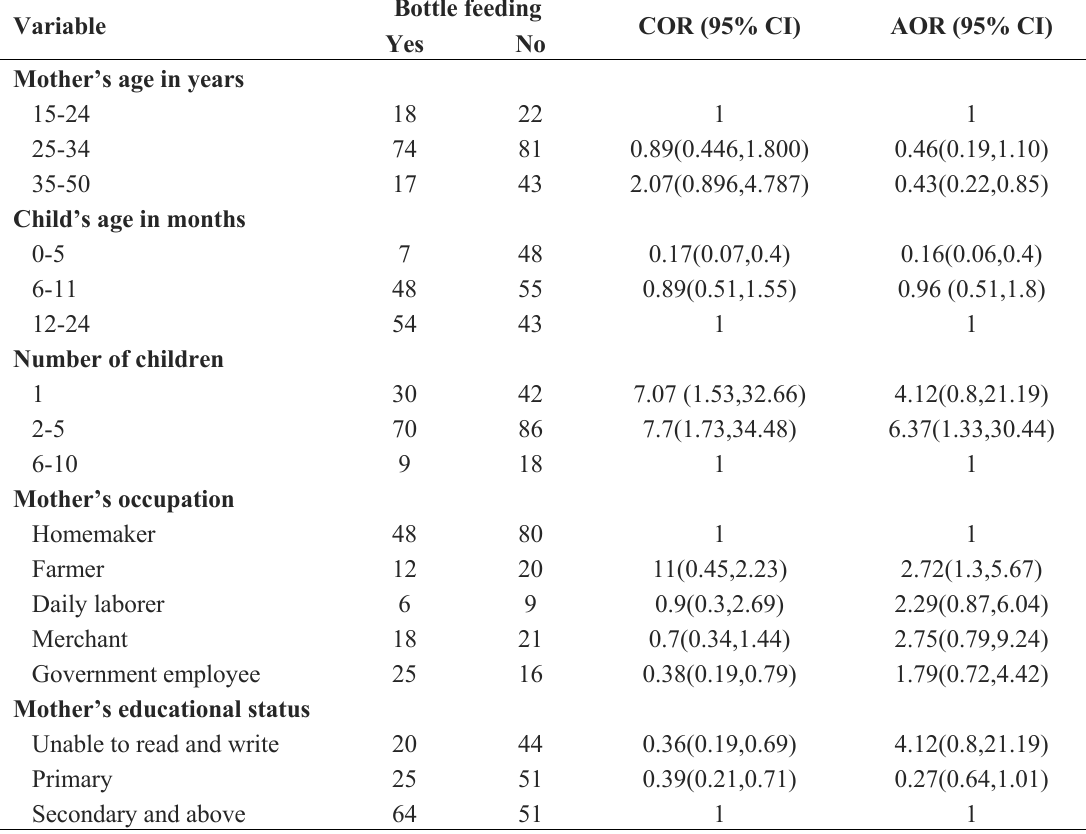
Table 5. Multivariable logistic regression analyses among mothers with infants less than 24 months of age in Woldia General Hospital, Ethiopia,